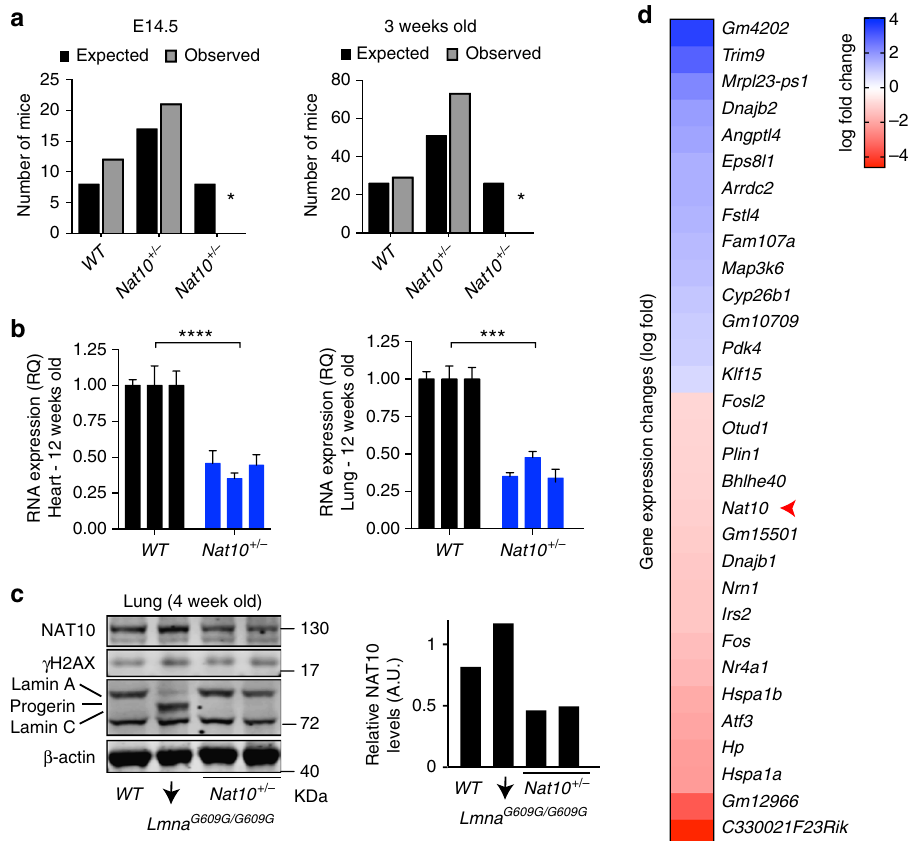
Fig. 3 Engineering and characterization of a Nat10 + / − mouse model. a Number of observed embryos (E14.5) and mice (21 days), compared to the expected numbers (Mendelian frequencies) (* p < 0.01; Chi-square analysis). b , c Nat10 + / − mice display ~50% reduction in Nat10 transcript level ( b each bar indicates individual mice ± s.d. of n = 5 technical replicates/mouse) or protein expression in the indicated tissues ( c representative western blot; blots have been performed more than once on n ≥ 3 mice), and the quanti fi cation is presented on the right panel, relative to actin levels. d Heatmap of genes differentially expressed in the heart of Nat10 + / − mice, compared to the wild-type, from RNAseq analysis ( n =